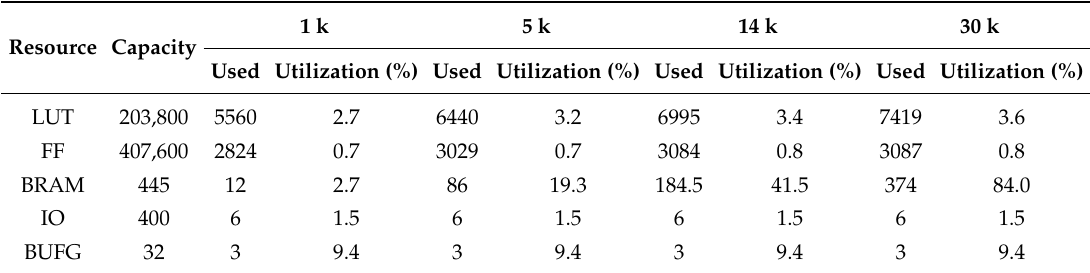
Table 9. Resource utilization.